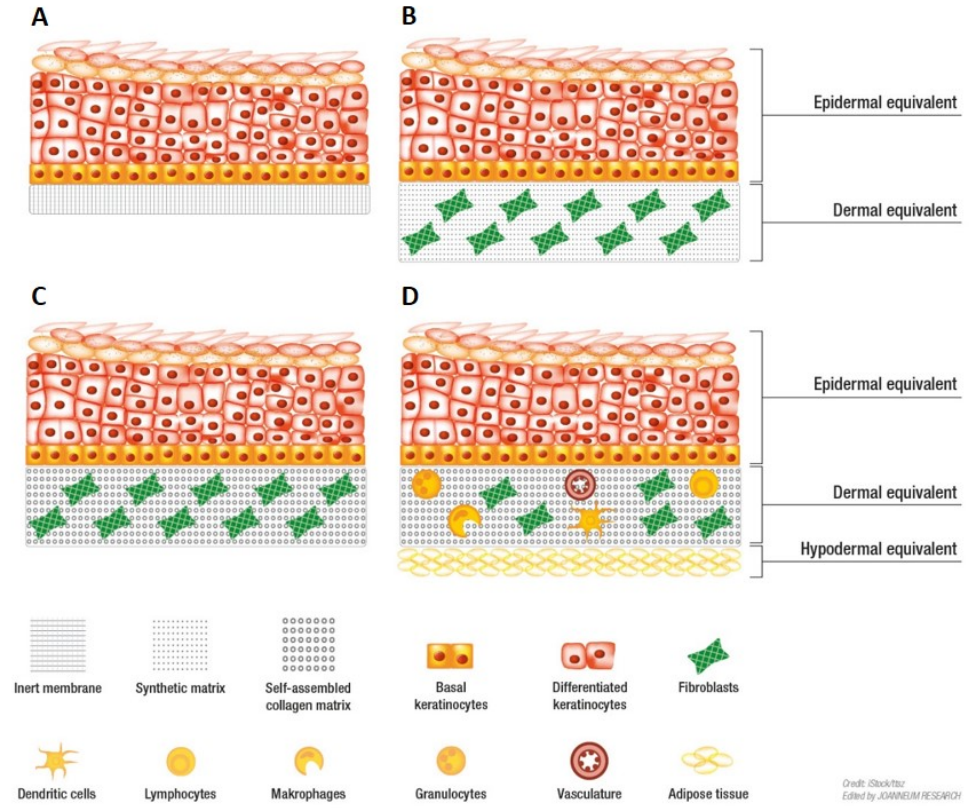
Figure 3. Evolution of human skin equivalents from reconstructed human epidermis (RHE) towards a fully functional, fully human skin model in vitro. ( A ) RHEs are generated by seeding and culturing keratinocytes on an inert matrix. Air-liquid-interface(ALI)-induced differentiation gives rise to a stratified epithelium that resembles a physiological epidermis [58,59]. ( B , C ) Reconstructed human skin (RHS) models feature a dermal equivalent where fibroblasts are grown in a synthetic matrix ( B ) [64–66]. Alternatively, fibroblasts can be induced to produce their own “natural” ECM ( C ) [67]. Keratinocytes are then seeded on top of the dermal equivalent and keratinocyte differentiation is induced by ALI. ( D ) An envisioned human skin model mimicking native human skin would consist of three layers, i.e. an epidermal, dermal and hypodermal equivalent. Moreover, a functional circu- lation, immune and nervous system would be of great interest. RHEs, some of which may be implemented in validated test procedures according to the EU Reference Laboratory for alternatives to animal testing (EURL-ECVAM) or the Or- ganization for Economic Co-operation and Development (OECD), are commercially avail- able for hazard assessments of the substances in accordance to the European Union regu- lation guidelines for registration, evaluation, authorization and restriction of chemicals (REACH) and can be obtained from a number of companies (Table 1). For quality assur- ance and standardization, the companies provide detailed information on cell types, cell handling, type of the construct, histology, immunohistochemistry, lipid analysis, as well as on permeability for standard substances and resistance to irritants [68]. In addition to these commercially available models, efforts have been made to also validate an open source RHE for in vitro toxicology testing [69–71]. Also pigmented RHE, which contains melanocytes of different phototypes in the basal layer of the epidermal construct, can be produced [72] or purchased. These model systems are used to analyze phototoxicity, or to test the effectiveness of commercially available sunscreens in a highly standardized man- ner [73,74].